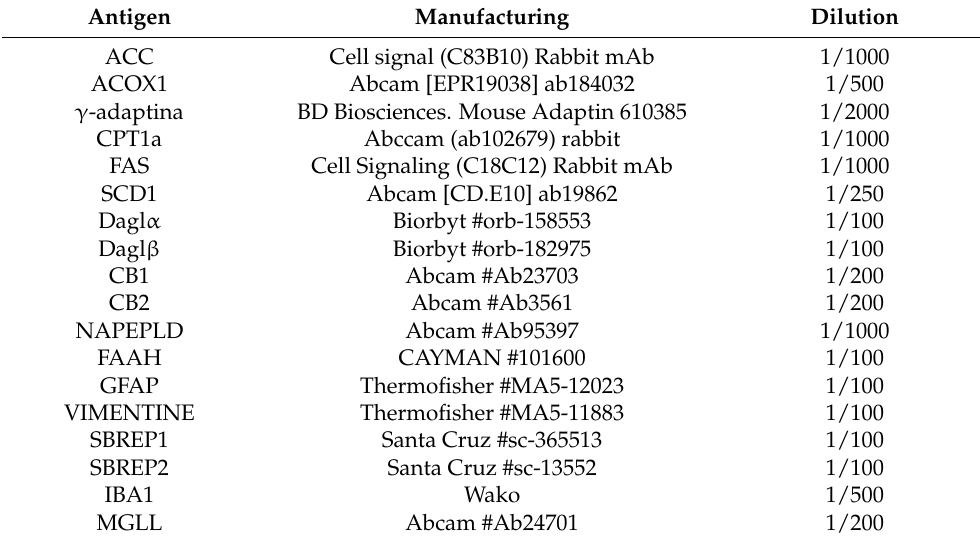
Table 2. Antibodies used for protein expression by Western